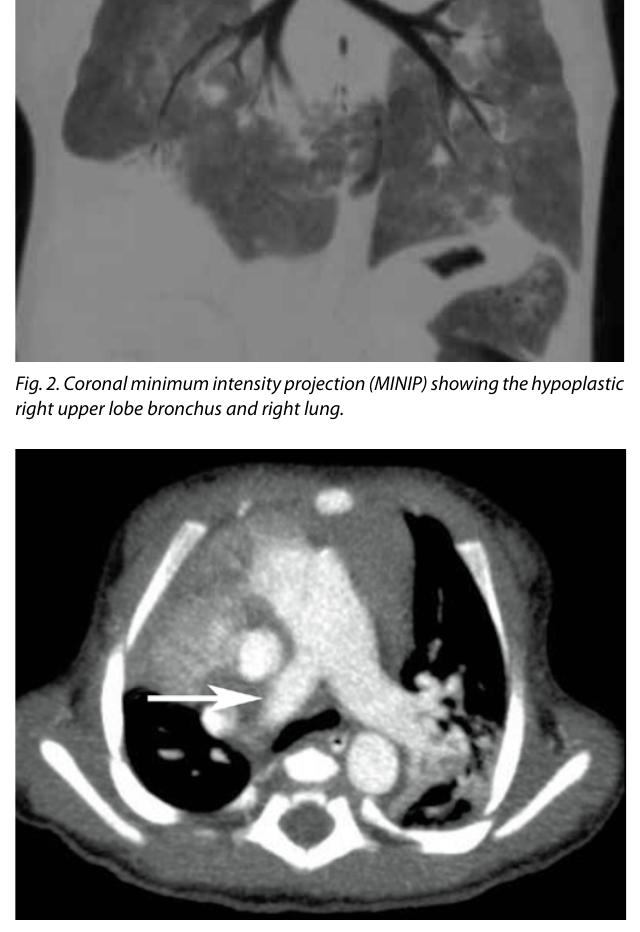
Fig. 3. Axial maximum intensity projection (MIP) showing the small right pulmonary artery (arrow).